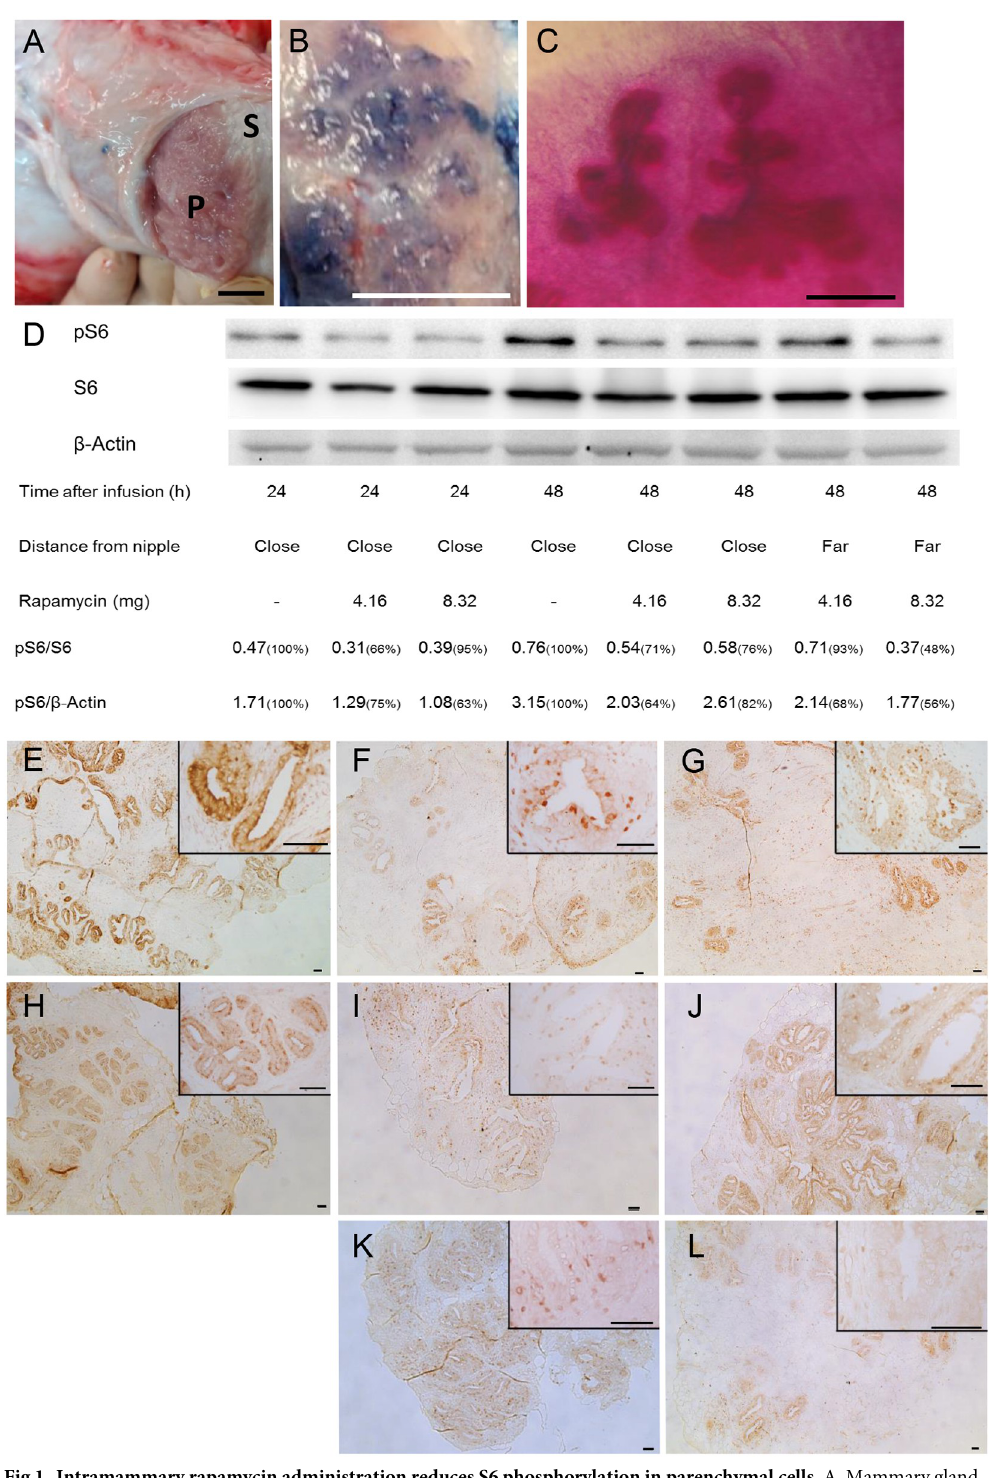
Fig 1. Intramammary rapamycin administration reduces S6 phosphorylation in parenchymal cells. A. Mammary gland morphology. P, parenchyma; S, stroma. Bar = 2 cm. B. Evans blue penetration of parenchyma, 2 h after administration. Bar = 1.25 cm. C. Mammary whole mount showing penetration of Evans blue into Carmine red-stained mammary epithelial structures. Bar = 1 mm. D. Immunoblot analysis showing a decrease in S6 phosphorylation (pS6) 24 and 48 h after rapamycin administration. E–G. Immunohistochemical analysis of S6 phosphorylation, 24 h after treatment, in regions close